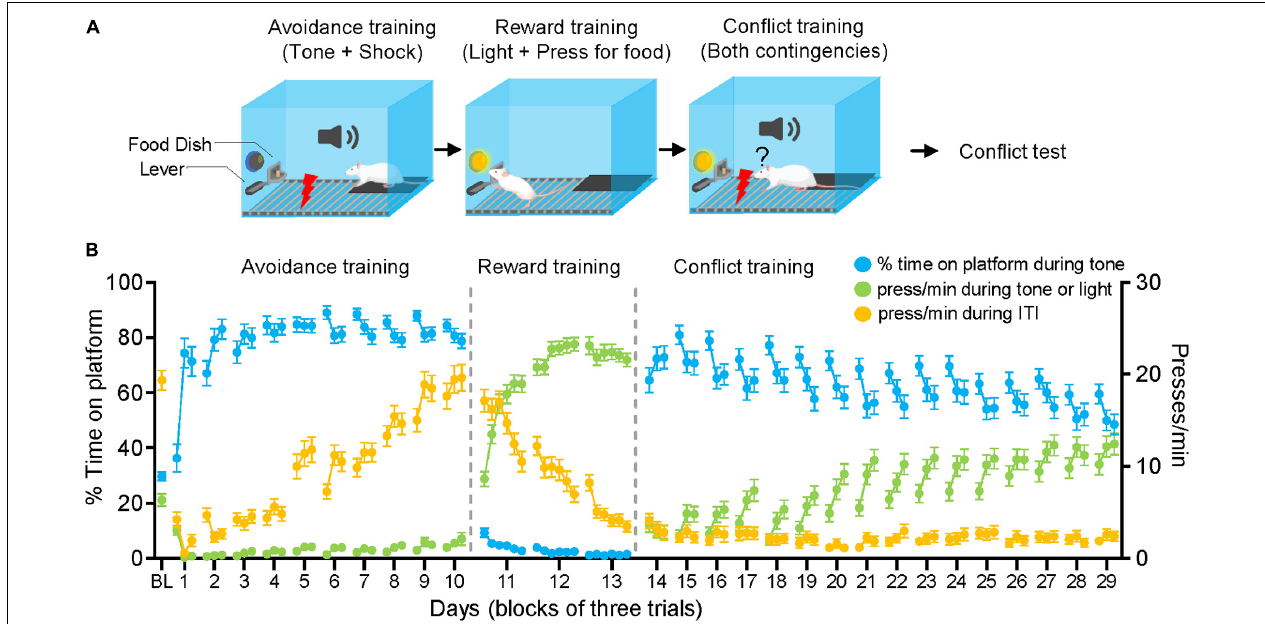
FIGURE 1 | Approach-avoidance conflict training. (A) Rats were given 10 days of avoidance conditioning followed by 3 days of reward conditioning and 16 days of conflict training. (B) As rats learned avoidance conditioning, they increased the time spent on the platform (blue line), while reducing pressing during the tone (relative to the baseline established during the first tone) (green line). The pressing during the intertrial interval (ITI) (ITI = 1 min prior to each trial) (orange line) returned to preconditioning baseline (BL) by the end of avoidance conditioning. During reward conditioning, rats decreased their pressing during the ITI and increased their pressing during the light (green line). When the tone-light were co-presented in conflict training, rats gradually reduced the time spent on platform and gradually increased their